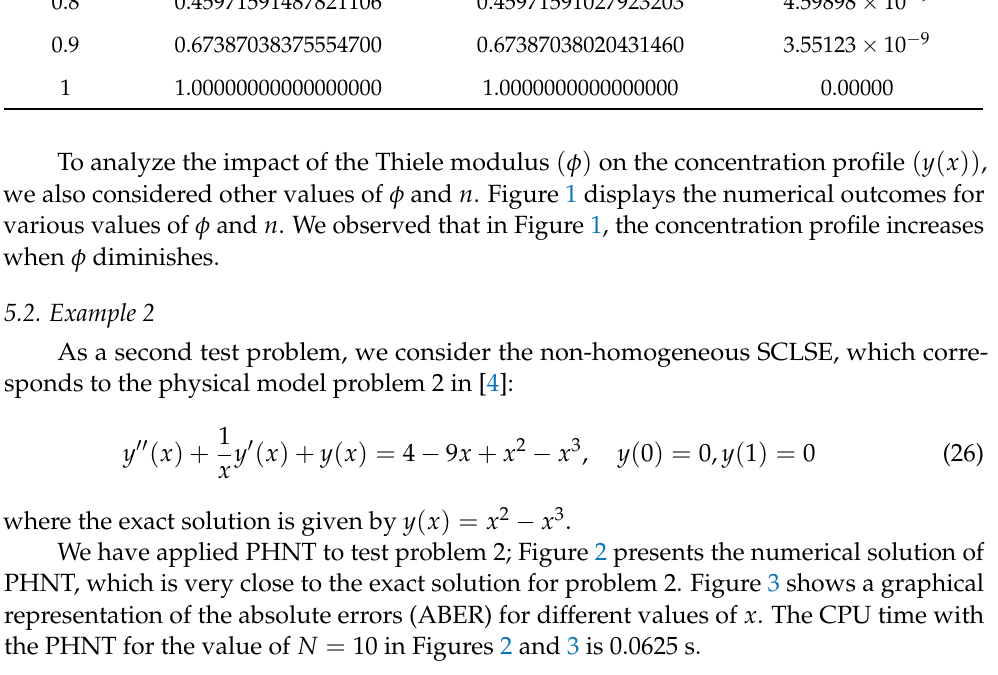
Table 1. Comparison of PHNT and the exact solution on test 1 with h = 1